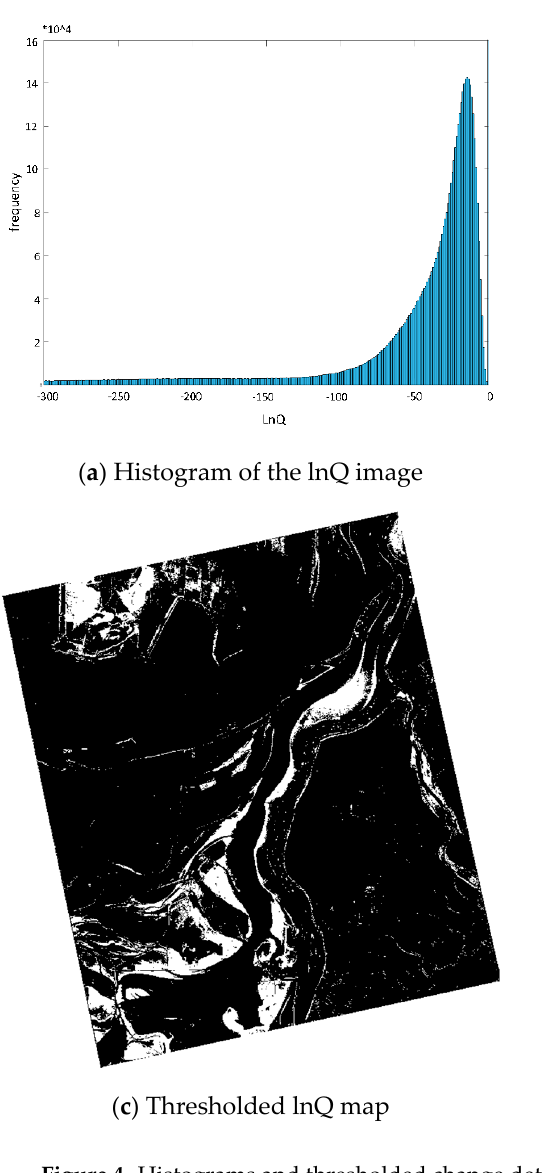
Figure 4. Histograms and thresholded change detection maps obtained using lnQ ( a and c , respectively) and Polarimetric Difference Image measures ( b and d , respectively).